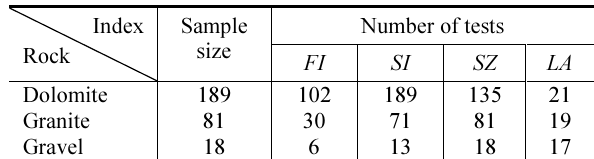
Table 1. Number of samples used for the